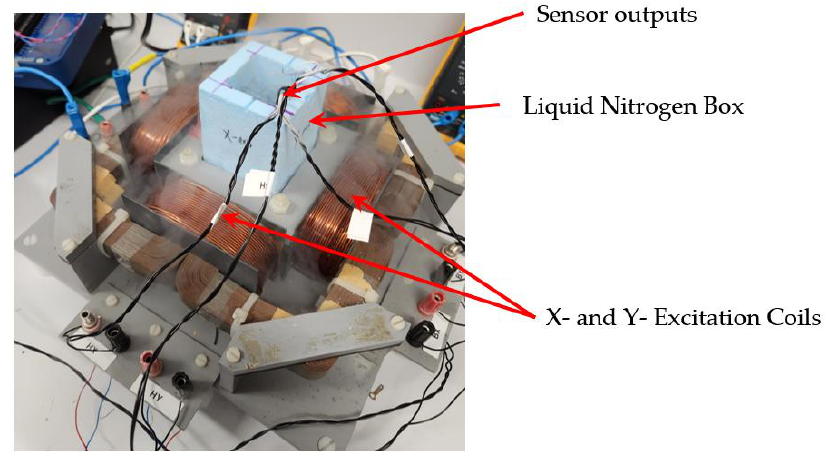
Figure 3. An image of SST installed with liquid nitrogen box.